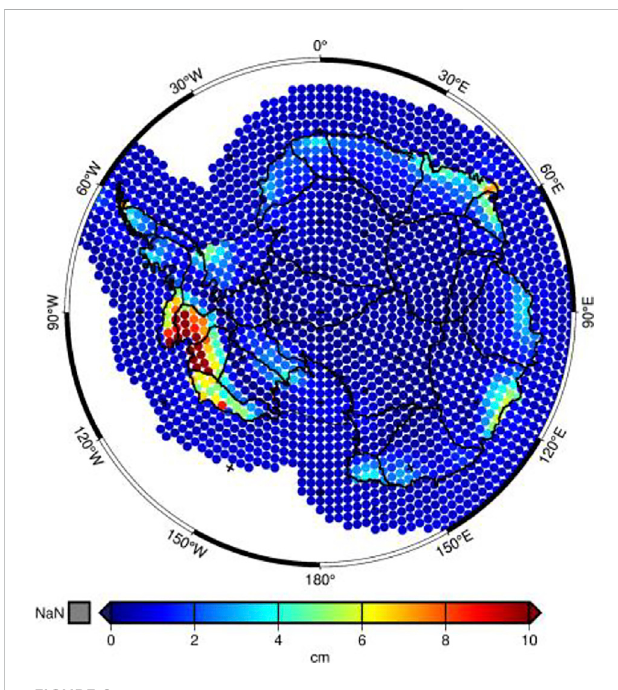
FIGURE 8 The mean MSE roots of 157 months for the 2024